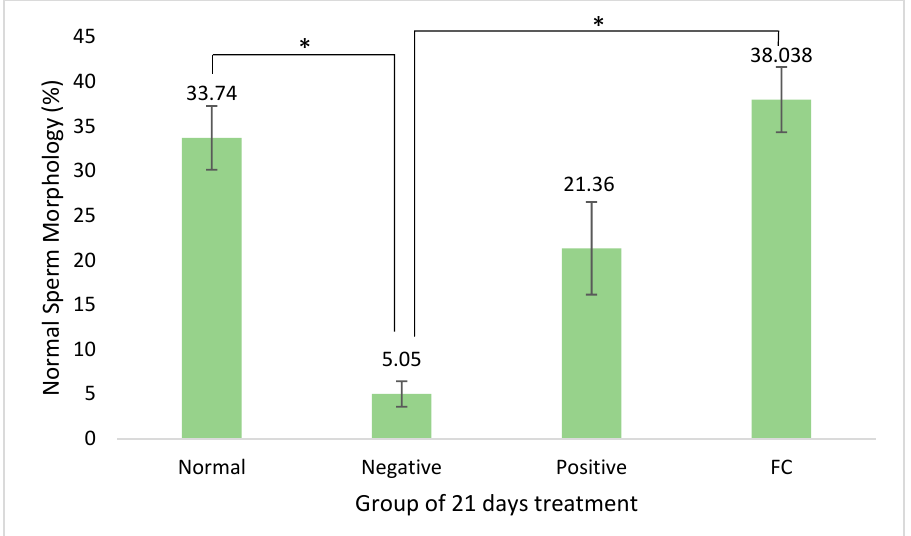
Figure 5. Normal sperm morphology (%) of rats from normal (normal group with distilled water), negative (diabetic group with distilled water), positive (diabetic group with 300 mg/kg metformin), and FC (diabetic group with 400 mg/kg Ficus carica aqueous extract). Symbol “ * ” represents significant difference ( p < 0.05).